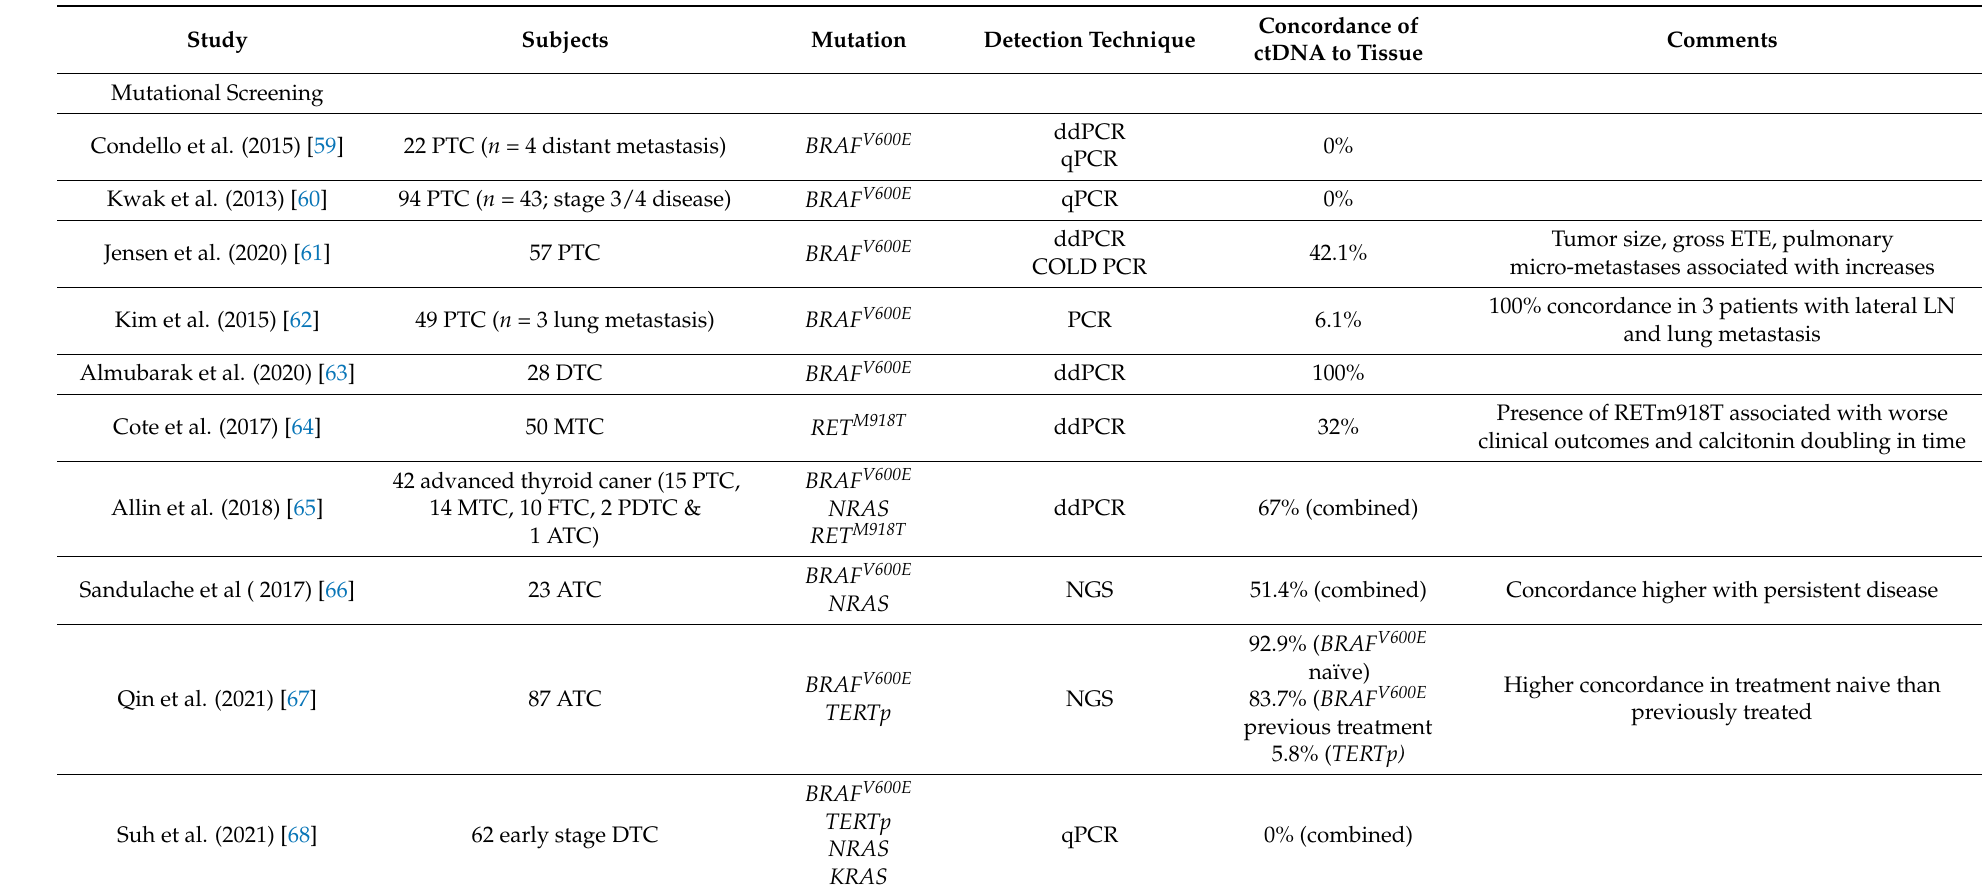
Table 1. ctDNA markers for the diagnosis and surveillance of thyroid